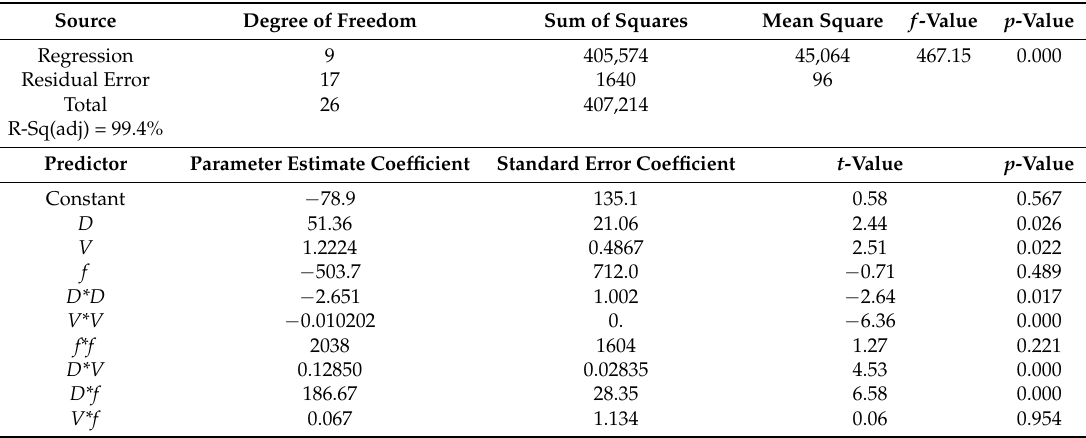
Table 3. ANOVA table for F z (thrust force).